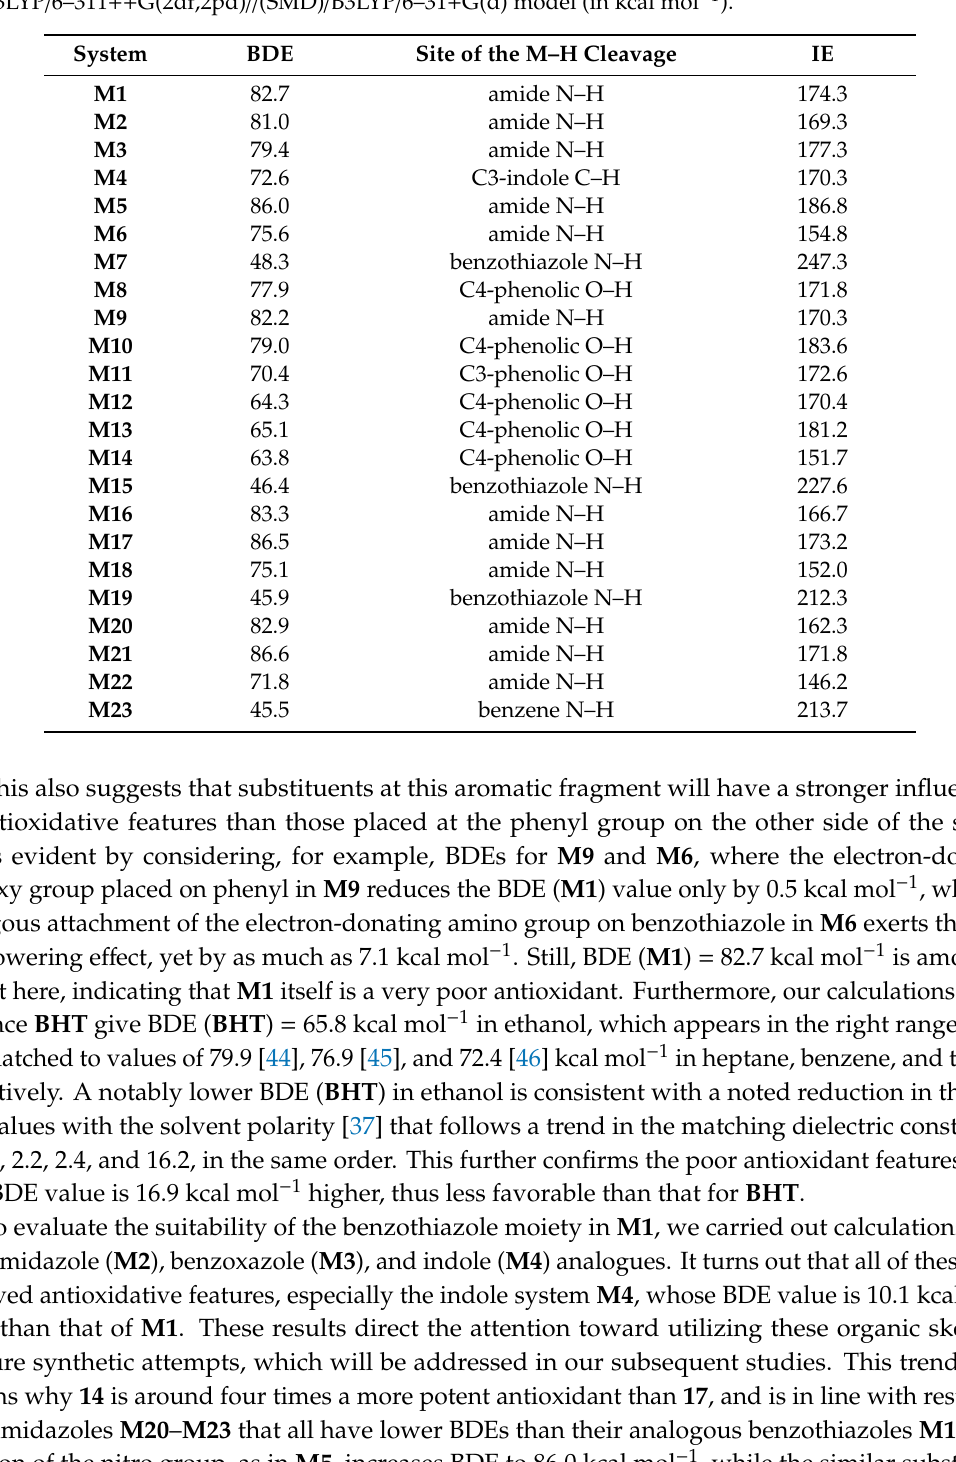
Table 3. Bond dissociation energies (BDE) and ionization energies (IE) in ethanol calculated by the B3LYP / 6–311 ++ G(2df,2pd) // (SMD) / B3LYP / 6–31 + G(d) model (in kcal mol − 1